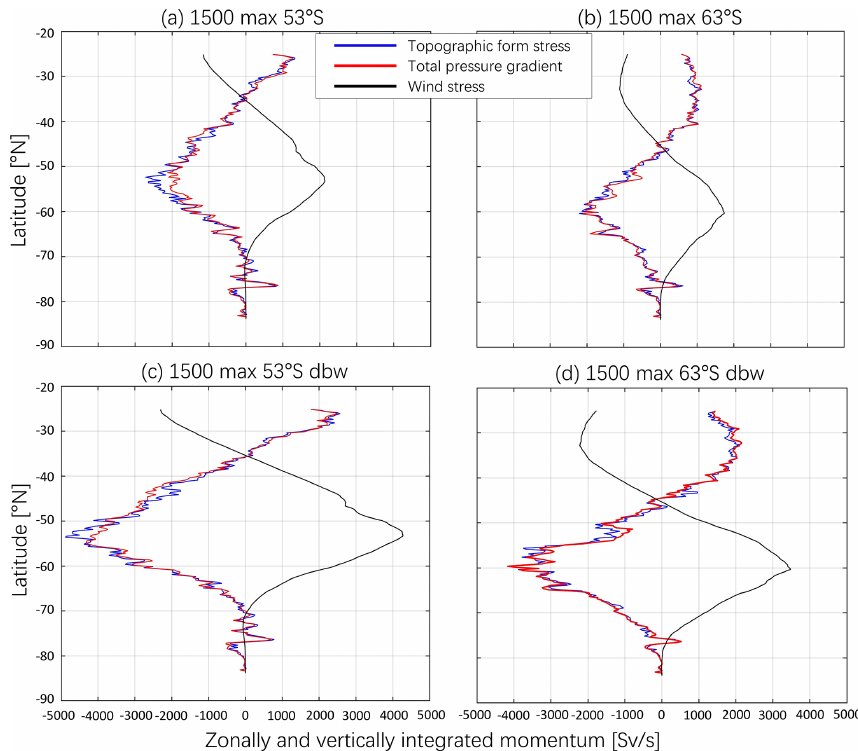
Figure B2. The zonally and vertically integrated values of the momentum budget between wind stress (black; Svs − 1 ), total topographic form stress (blue; Svs − 1 ) and total pressure gradient (red; Svs − 1 ) in the 1500_max_53 ◦ S (a) , 1500_max_63 ◦ S (b) , 1500_max_53 ◦ S_dbw (c) and 1500_max_63 ◦ S_dbw (d)